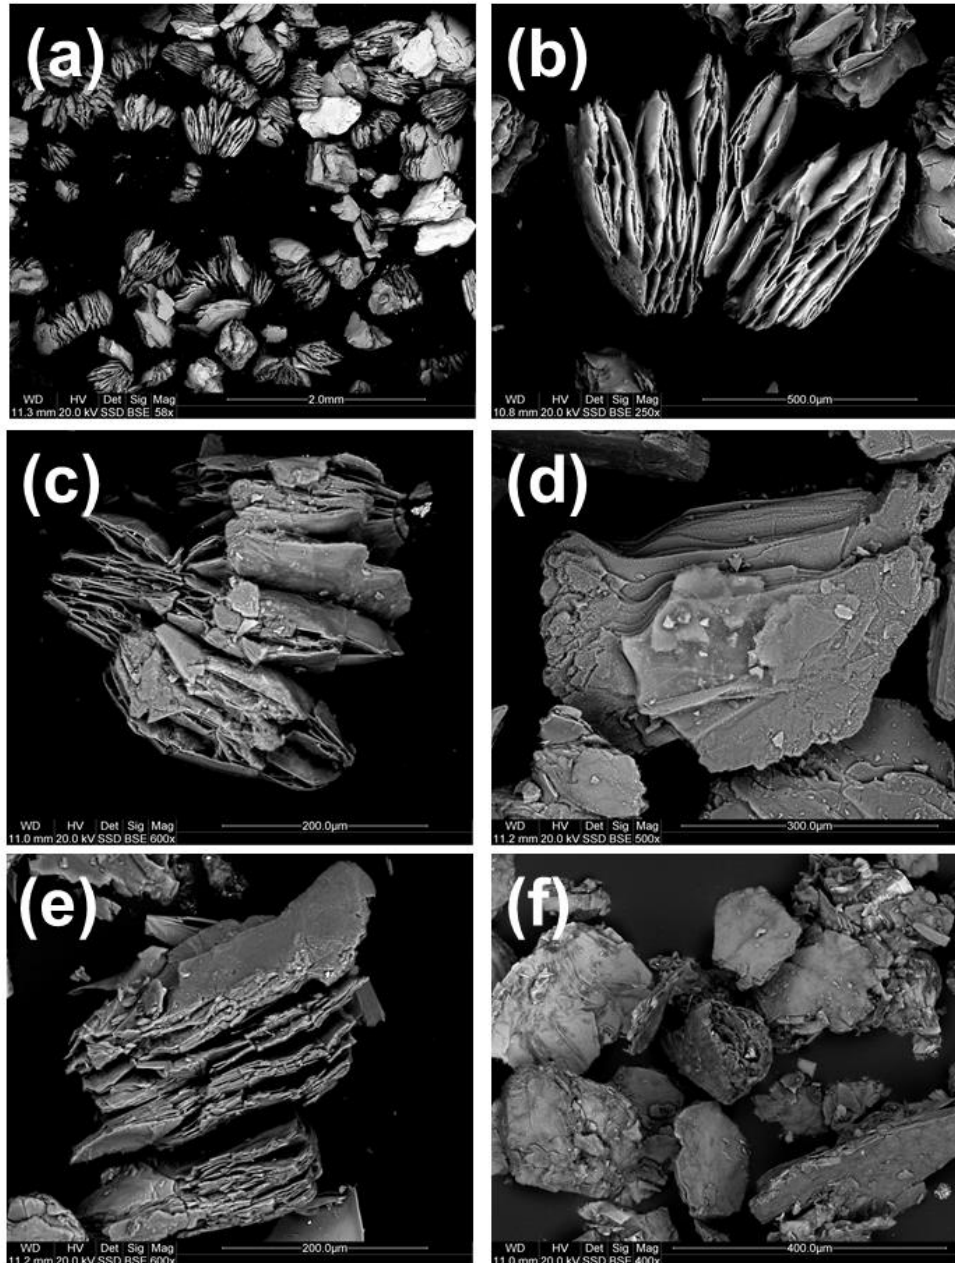
Figure 7. SEM images of: ( a ) VER, ( b ) VER, ( c ) 0.5 HDTMA, ( d) 2.0 HDTMA, ( e ) 0.5 HDBA, and ( f ) 2.0 HDBA.